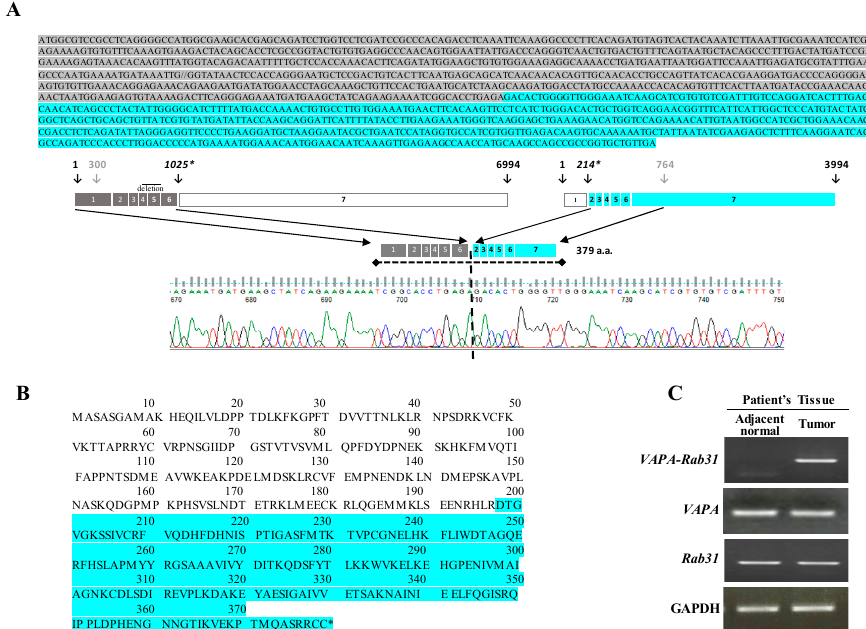
Figure 1. The VAPA-Rab31 fusion gene is highly expressed in tumor tissue of a patient with lung adenocarcinoma. ( A ) The VAPA and Rab31 exon structures are indicated. The schematic representation of the VAPA-Rab31 fusion gene, with the exons from each gene, is also shown. The breakpoint of the fusion gene was confirmed by Sanger sequencing chromatogram. ( B ) Amino acid sequences of fusion gene: different colors are used for the two gene product (grey: VAPA; blue: Rab31). ( C ) The overexpression of VAPA-Rab31 was confirmed by RT-PCR in the patient’s tumor tissue.